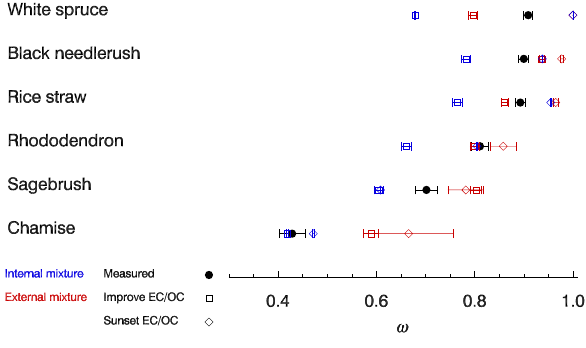
Fig. 3. Values of ω meas derived from measured values of aerosol scattering and absorption coefficients (black circles). Blue and red symbols indicate ω calculated from aerosol composition us- ing external (blue) and internal (red) mixture models, for two mea- surements of carbonaceous components: EC/OC values from the IMPROVE filters and TOR protocol (squares) and EC/OC val- ues from the hi-vol filters analyzed by the Sunset instrument and NIOSH protocol (diamonds). Horizontal bars indicate the range of values produced by the extremes of EC properties (Table 3). In the composition-based calculations, size distributions applied were those shifted by the shape factors indicated in Table